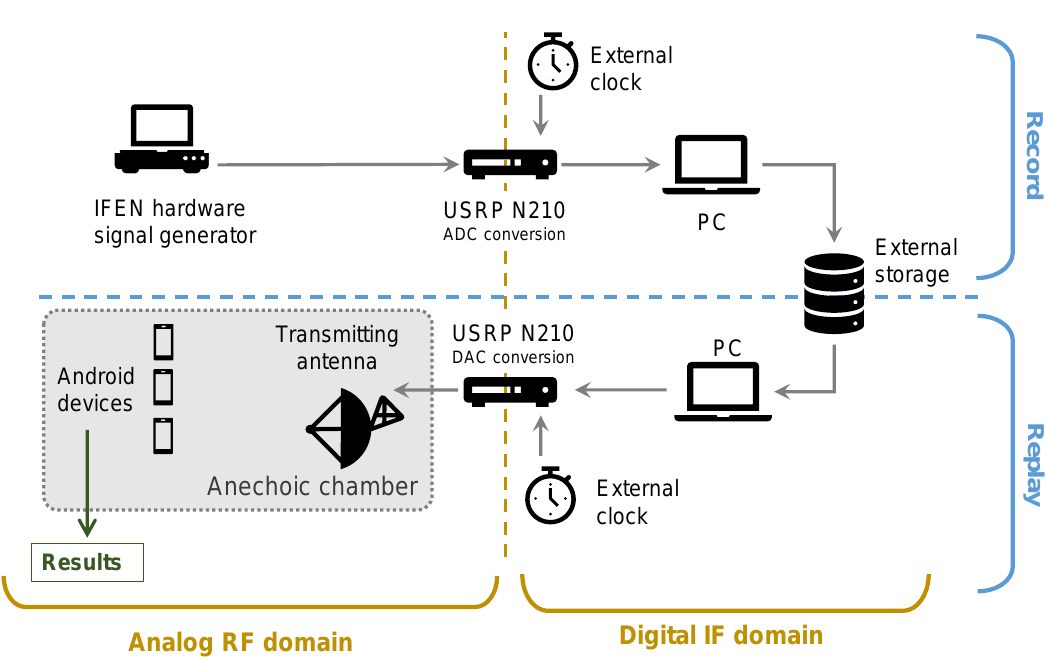
Figure 7. Record and Replay equipment and configuration for controlled experiments.